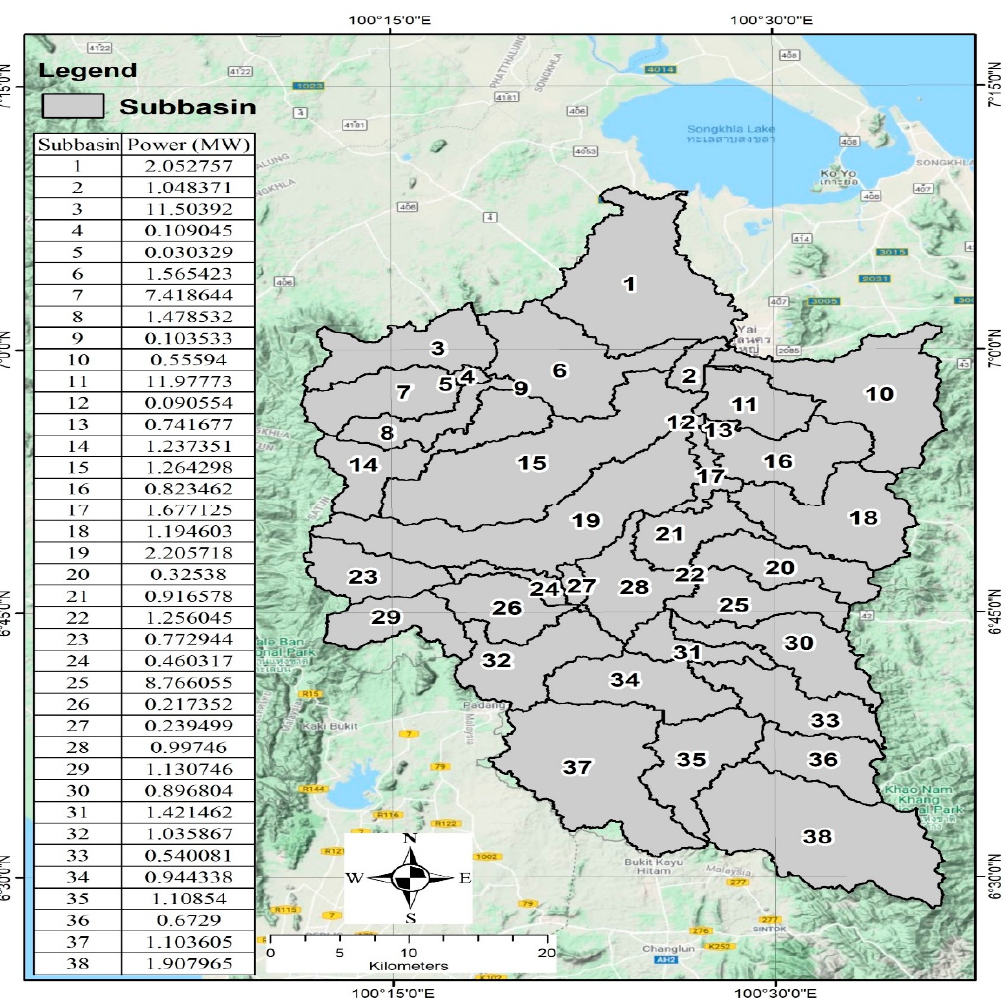
Figure 8. Theoretical hydrokinetic power potential of the URB .